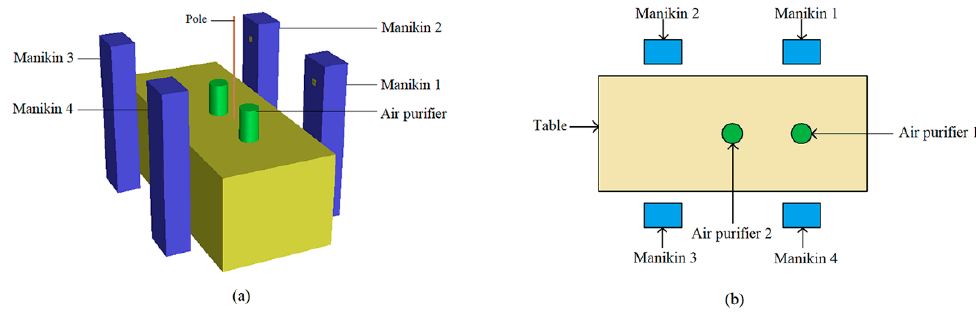
Figure 2. CFD model of the single table case: ( a ) axonometric view; ( b ) top view. Table 1. Geometries of the single table case.